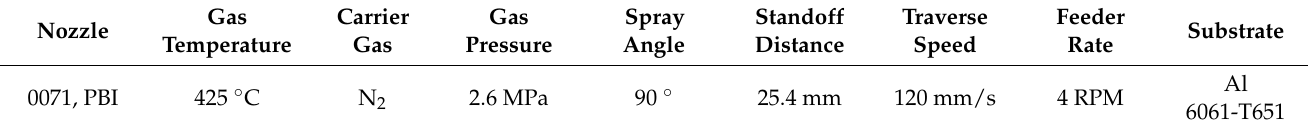
Table 2. Cold Spray processing